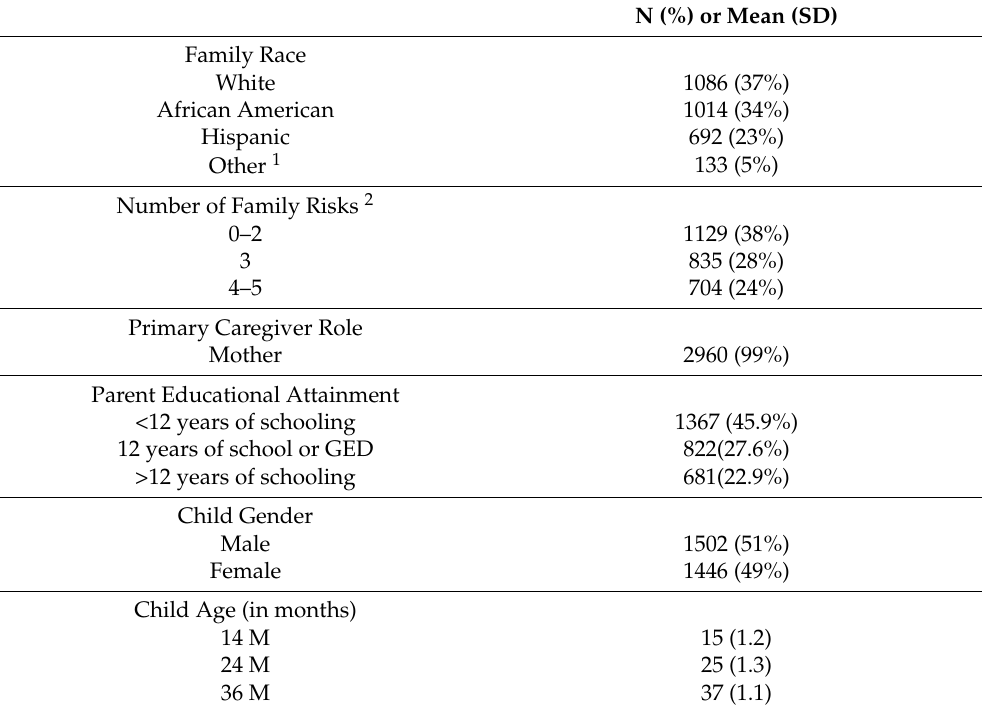
Table 1. Additional Family